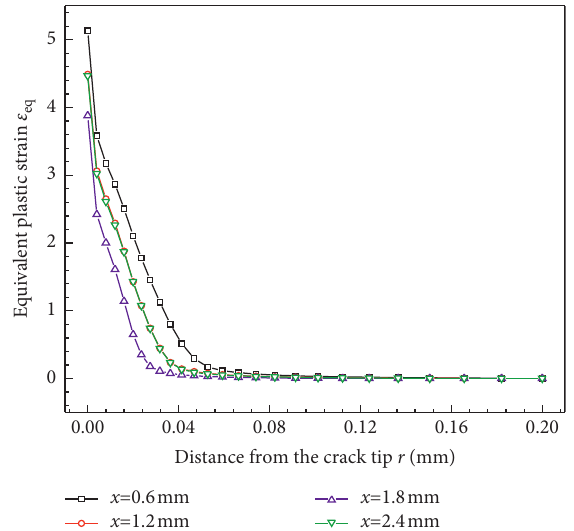
Figure 13: Equivalent plastic strain curves at the front of initiation crack tip.